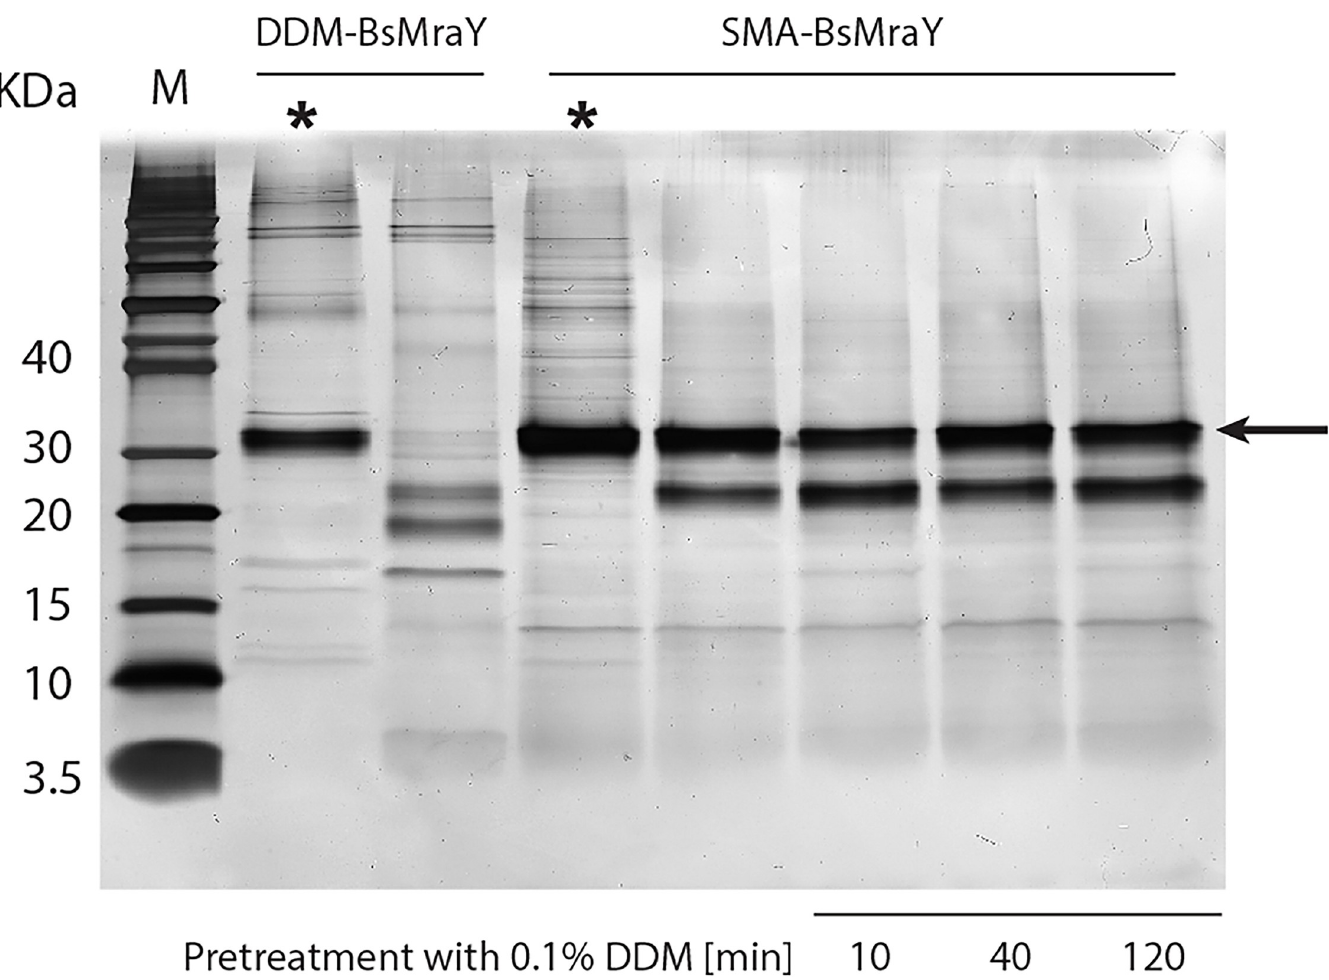
Fig 9. LysC treatment (37 ˚C, 10 min) of DDM-MraY and SMA-MraY. The influence of 0.1% DDM on the stability of SMA-MraY in the presence of LysC is shown after 10, 40 and 120 min incubation with the detergent at a final concentration of 0.1%. The lanes with the untreated protein are annotated with ( � ). M indicates the protein marker and the sizes (in kDa) are shown on the left side of the ladder. Intact MraY displays a molecular weight of about 31 kDa and is indicated by a black arrow.